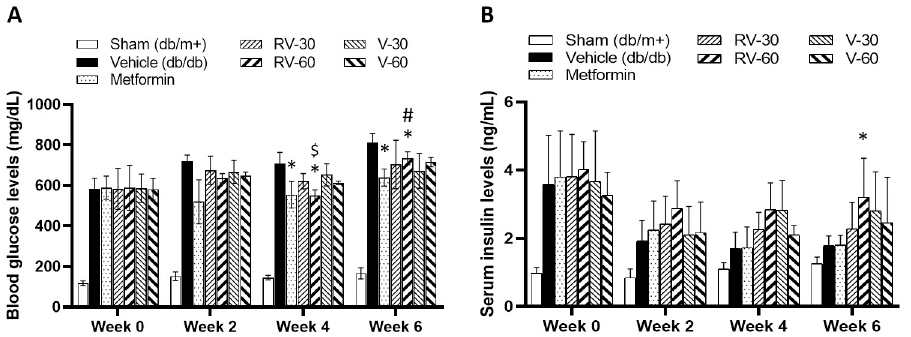
Fig 6. Effects of Verapamil (V) and R-Vera (RV) on BG and serum insulin in db/db mice. (A) BG and (B) serum insulin levels were measured on weeks 0 (before treatment), 2, and 4 and on day 6 in mice fasted 6 h. � P < 0.05 compared to vehicle ( db / db ); # P < 0.05 compared to metformin; $ P < 0.05 compared to RV-30; two-way ANOVA. N = 5 per group except for n = 3 and n = 2 in V-60 group on weeks 2 and weeks 4 and 6, respectively, because of animal health issues. Data are expressed as means ± SD.